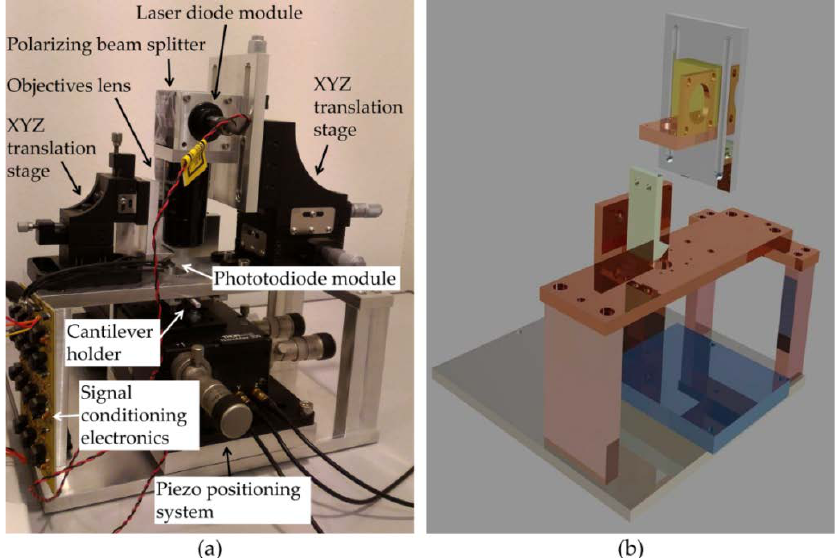
Figure 2. Atomic force microscopy (AFM) system: ( a ) Experimental setup. The system consists of